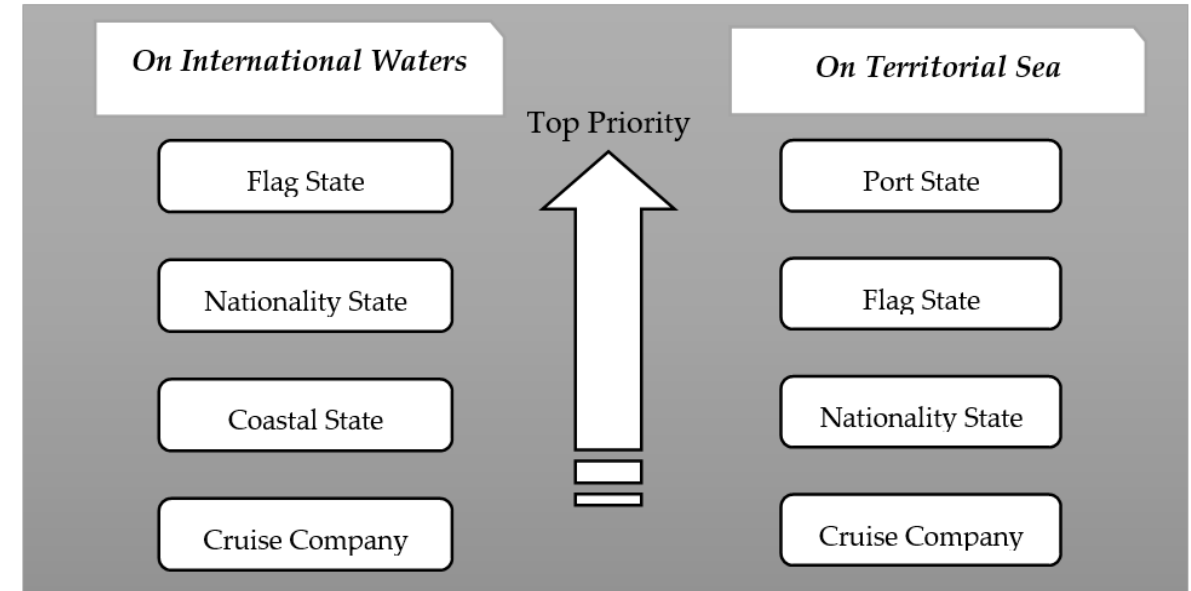
Figure 1. Priority Order of Stakeholders undertaking Responsibilities.